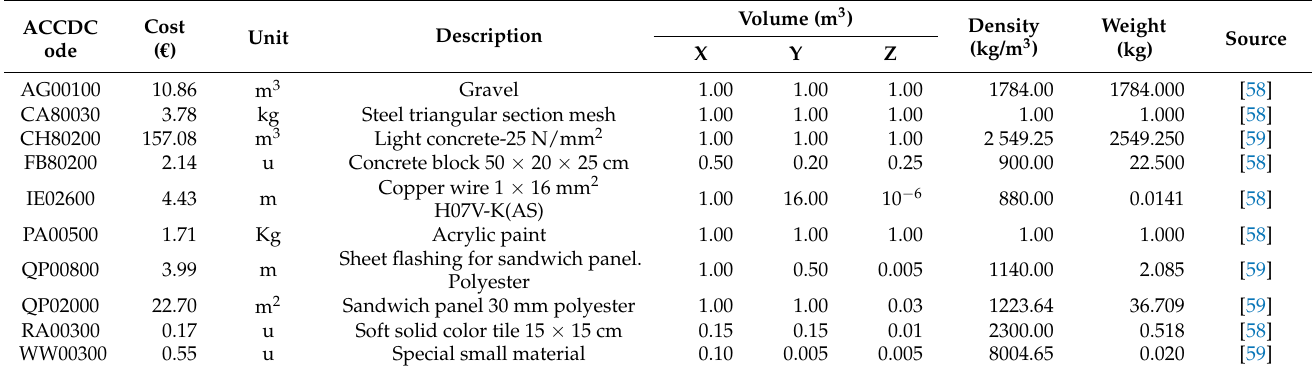
Table 1. Weight calculation of basic construction